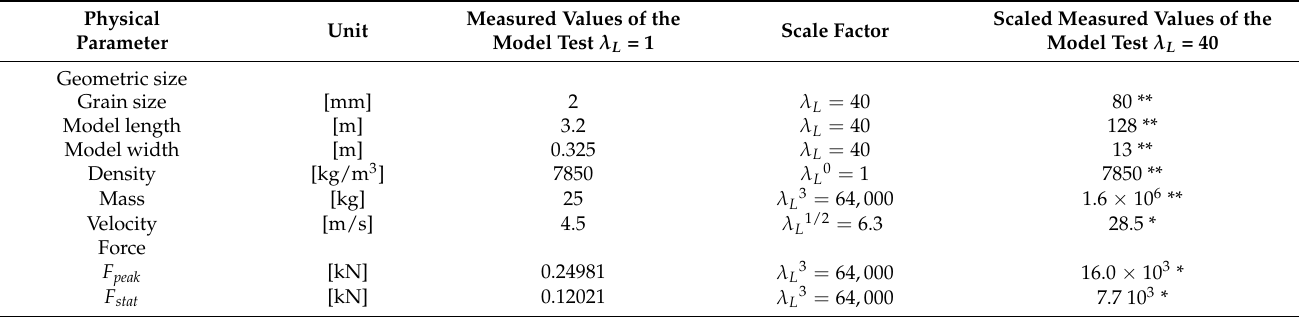
Table 9. Comparison of the parameters with the scale factor λ L = 1 and λ L = 40.